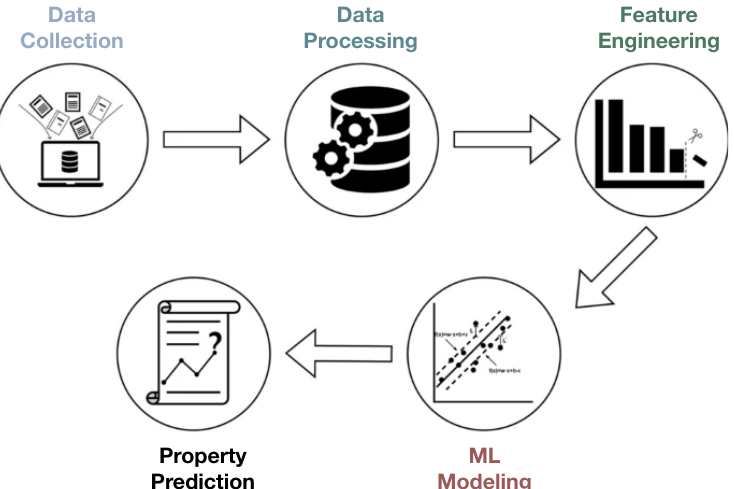
Figure 2. Main steps towards property predictions through the use of ML frameworks, driven by feature engineering in materials science. For mechanical deformation, multiscale microscopy and testing experimental data, as well as multiscale modeling data are used as input, that may exceed 1PB. From there, a key step involves data processing and reduction approaches [45,46], that may allow the derivation of meaningful features that capture key physical mechanisms. As soon as features are consistently defined, property prediction and machine learning models are built. Currently, the biggest challenge is focused on feature engineering and data management. Redrawn based on Ref.